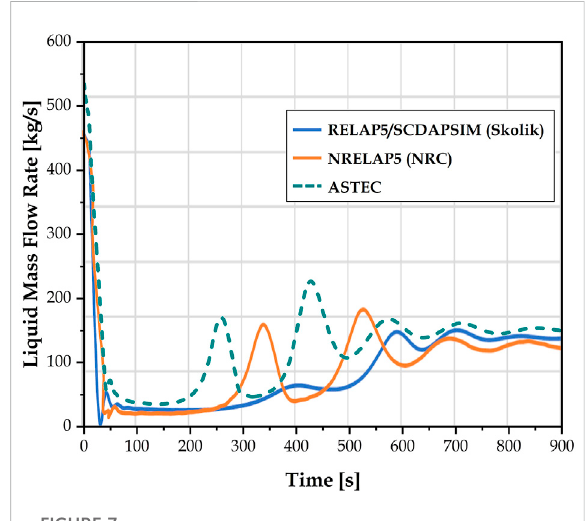
FIGURE 7 Turbine trip transient: Primary coolant mass fl ow rate. CESAR